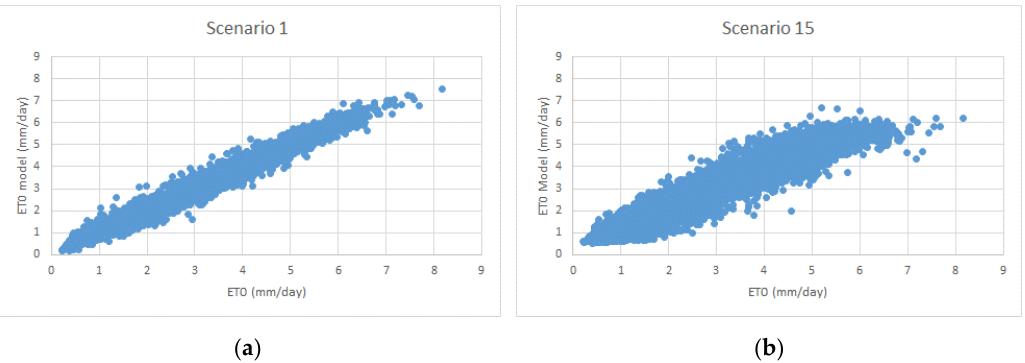
Figure 5. Scatter plot of M5P method for ( a ) Scenario 1 and ( b ) Scenario